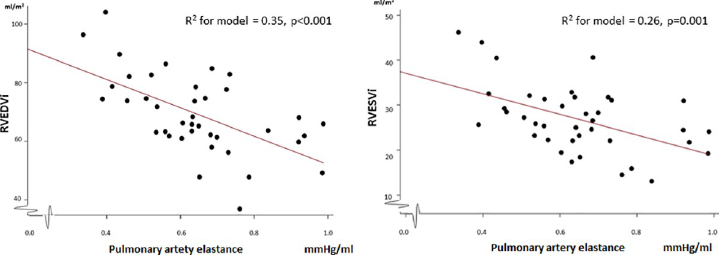
Fig 2. Association between RV end-diastolic and end-systolic volume indices and pulmonary artery elastance at maximal exercise. RVEDVi = right ventricular end-diastolic volume index, RVESVi = right ventricular end-systolic volume